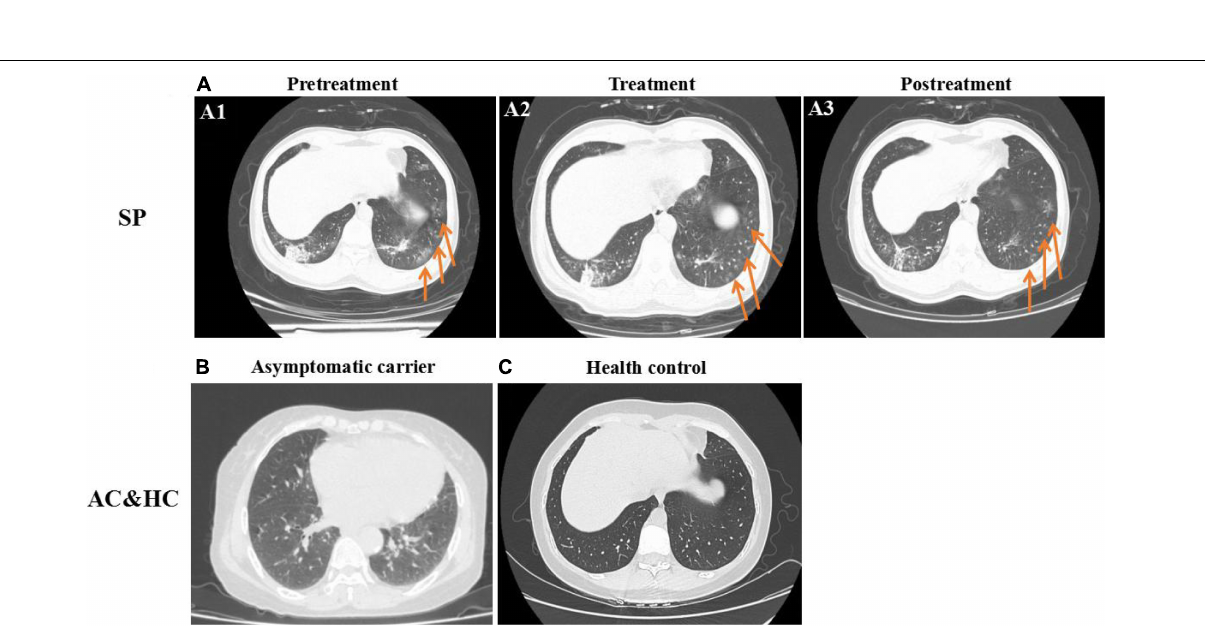
Frontiers in Microbiology |